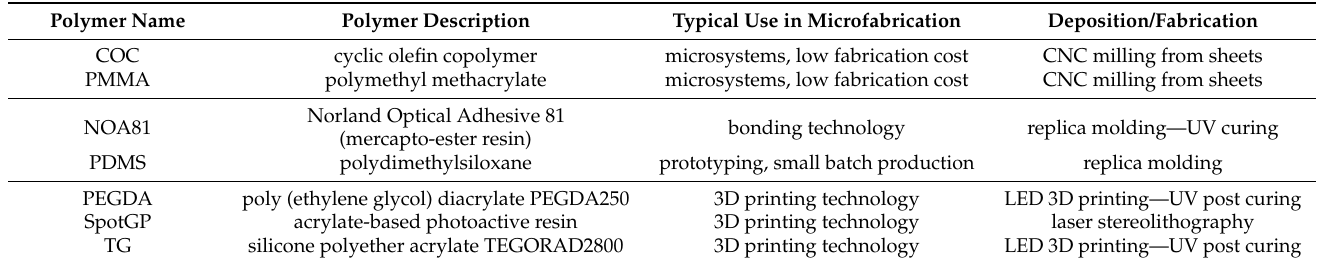
Table 1. Polymer materials tested in this study. Name, description and main features are